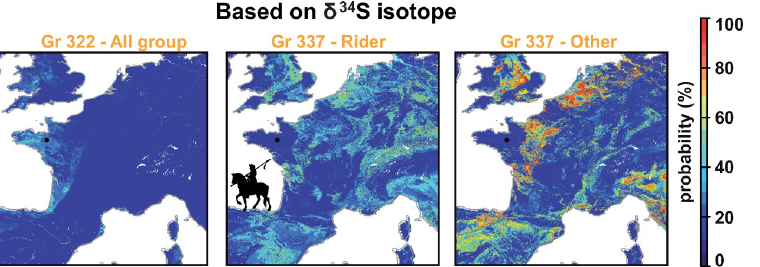
Fig 7. Maps showing the location of residence of all recovered individuals (for which bones were available) towards the end of their life. Maps of possible geographical origins are based on δ 34 S values. The probability maps are averaged by group: Gr. 322: 4 individuals; Gr 337 riders: 3 individuals identified as riders; Gr. 337; Other: 18 individuals. To generate these figures see Bataille et al., in this issue [13].